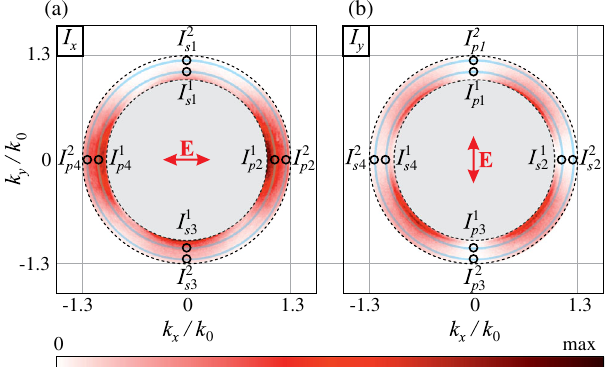
FIG. 3. Polarization-resolved BFP images. Panels (a) and (b) show exemplarily measured x - and y -polarized BFP images in the angular range defined by 1 ≤ k ⊥ =k 0 ≤ 1 . 3 . Both images are normalized to their common maximum value. The inner dashed black circle corresponds to the critical angle k ⊥ =k 0 ¼ 1 . The inner and outer semitransparent blue circles indicate k ⊥ 1 =k 0 ≡ 1 . 1 and k =k ≡ 1 . 25 . The outer dashed black circle indicates ⊥ 2 0 k =k ¼ 1 . 3 , representing the NA of the collection objective. An ⊥ 0 additional eight small black circles mark regions in the BFP, for which an averaged intensity value is determined, I j si and I j pi , with i ¼ 1 , 2, 3, 4 indicating the azimuthal position and j ¼ 1 , 2 referring to k ⊥ 1 and k ⊥ 2